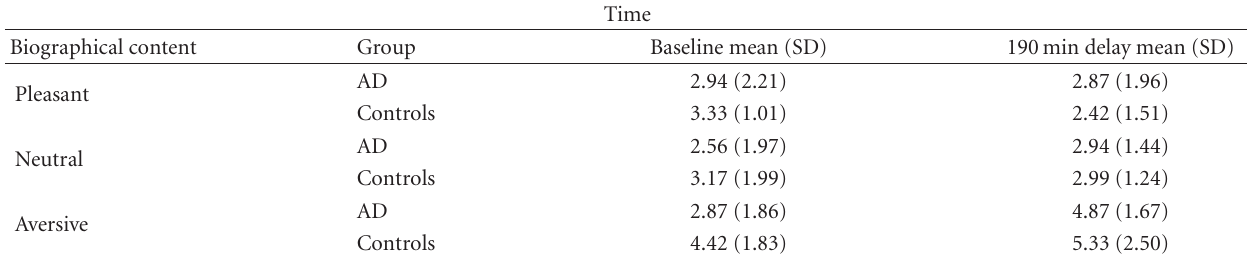
Higher ratings denote higher arousal. SD: standard